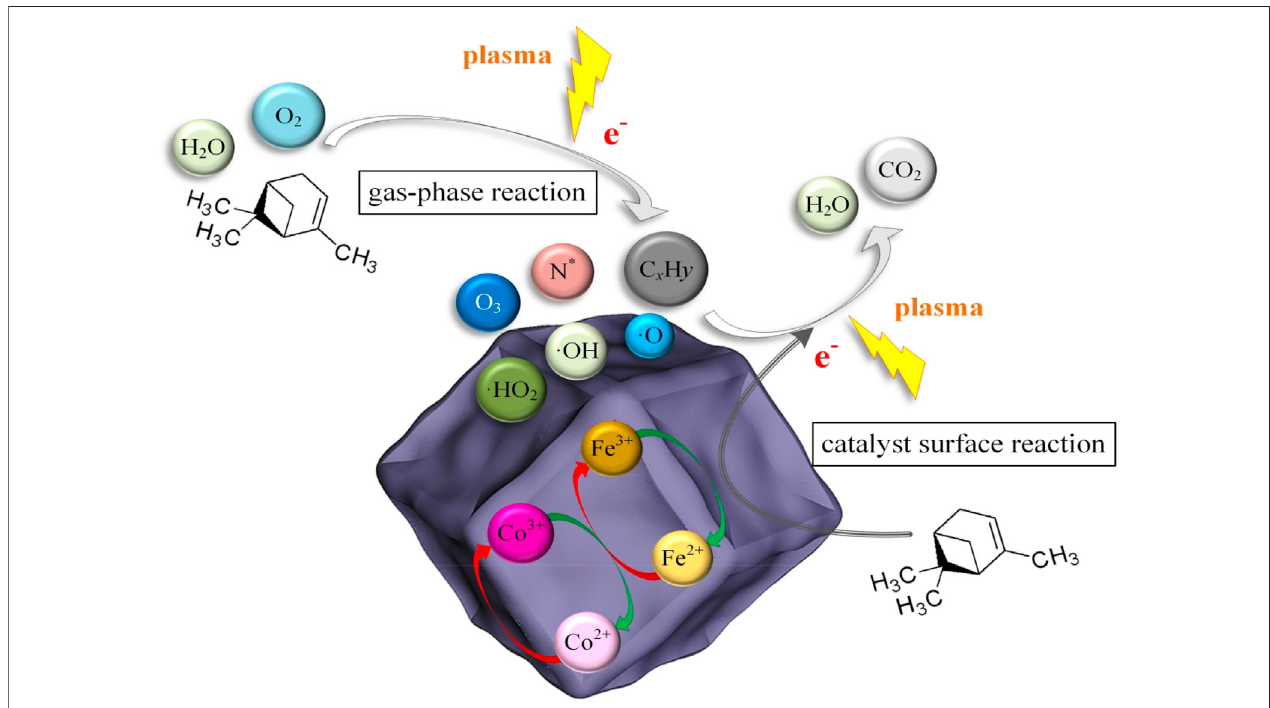
FIGURE 7 | Mechanism diagram of ZIF synergistic NTP catalyzing α -pinene